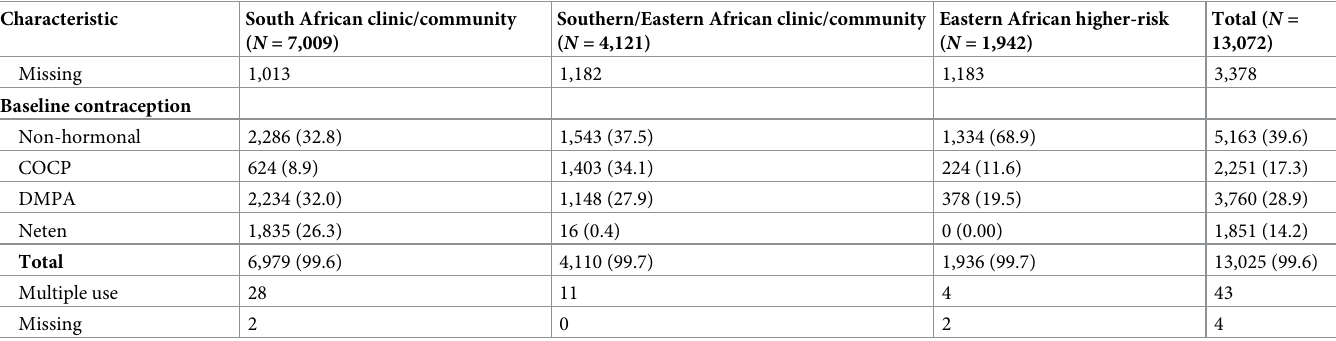
Gonorrhea. For women aged 15–24 years in clinic/community-based populations in South Africa, estimates of gonorrhea prevalence ranged from 1.4% to 8.9% in individual stud- ies, and the summary estimate was 4.6% (95% CI: 3.3%, 6.4%; I 2 = 82.8%) (Fig 3). The sum- mary estimate of gonorrhea prevalence in clinic/community-based populations in Southern/ Eastern Africa was 1.7% (95% CI: 1.2%, 2.6%; I 2 = 55.2%). In the higher-risk populations in Eastern Africa, estimates in individual studies ranged from 5.2% to 15.2%, with a summary estimate of 8.2% (95% CI: 5.8%, 11.6%; I 2 = 80.7%). As for chlamydia, prevalence of gonorrhea among women aged 25–49 years was generally lower than among women aged 15–24 years across all strata, and heterogeneity in all strata was high (Fig 4). Syphilis, overall (high, low, and unknown titer infection). Among 15–24-year-old women, the summary estimate of syphilis prevalence overall (i.e., proportion of participants with a positive RPR and positive treponemal test) was less than 2% in clinic/community popu- lations in both South Africa (1.5% [95% CI: 1.0%, 2.2%]; I 2 = 57.7%) and Southern/Eastern